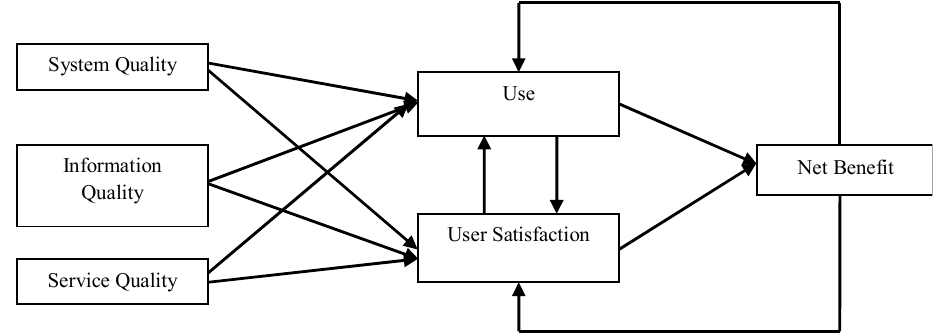
Fig. 1 Updated DeLone & McLean IS Success Model